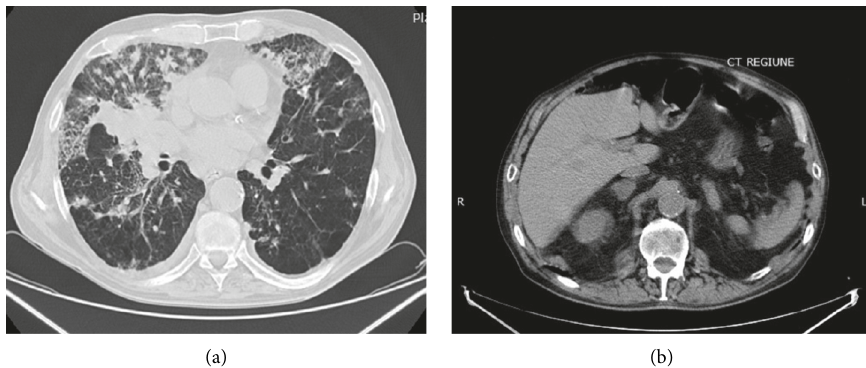
Figure 1: Thoracic CT at the initial diagnosis, without intravenous administration of contract material (increased creatinine levels): (a) dense mediastinal pulmonary mass localized in the medium lobe of the right lung, which meets the pulmonary hilum, and cannot be separated from the mediastinal structures, mediastinal, and retrocrural lymphadenopathies; (b) adrenal glands with diffuse increased sizes and spontaneous tissue